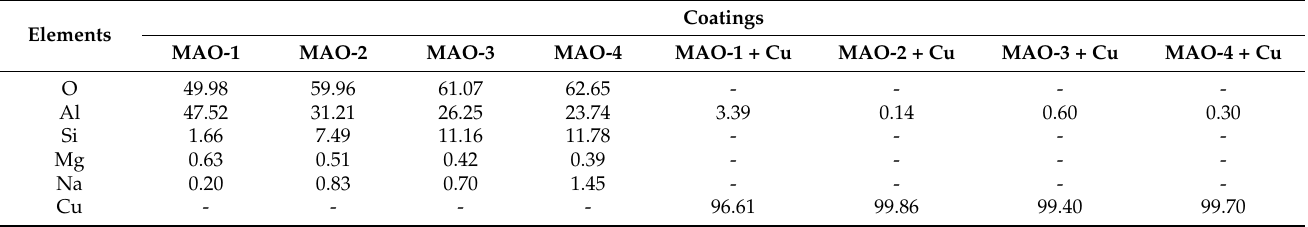
Table 2. EDS analysis of the MAO coatings surface before and after the electroless copper plating (at.%).